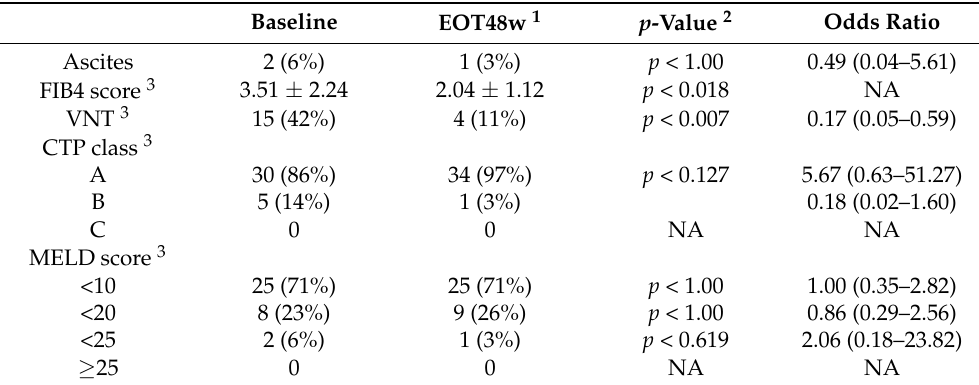
Table 3. Changes in clinical risk factors due to anti-HCV therapy.